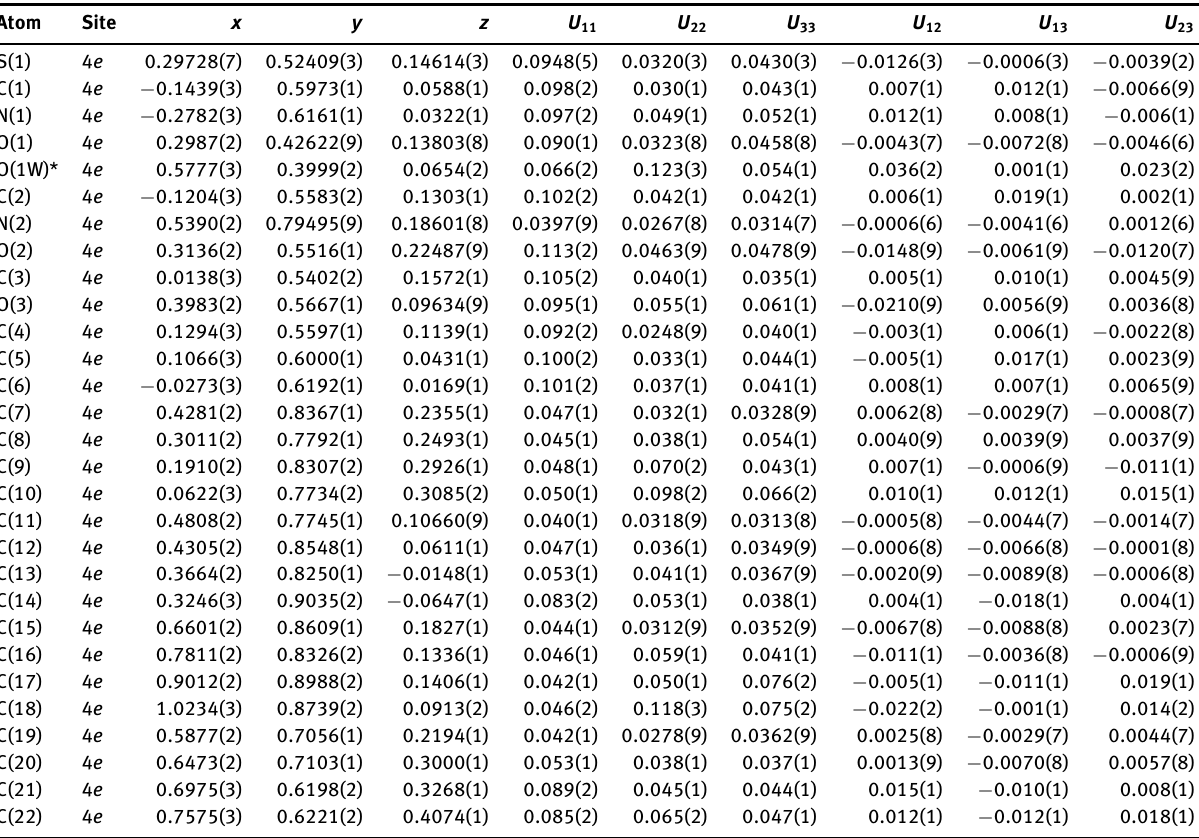
Table 3: Fractional coordinates and atomic displacement parameters (Å 2 ); * occupancy =